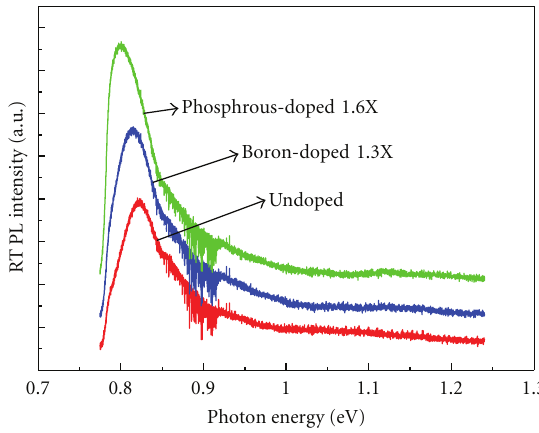
Figure 8: Room temperature photoluminescence of tensile- strained Ge on Si with delta-doping SiGe layers.